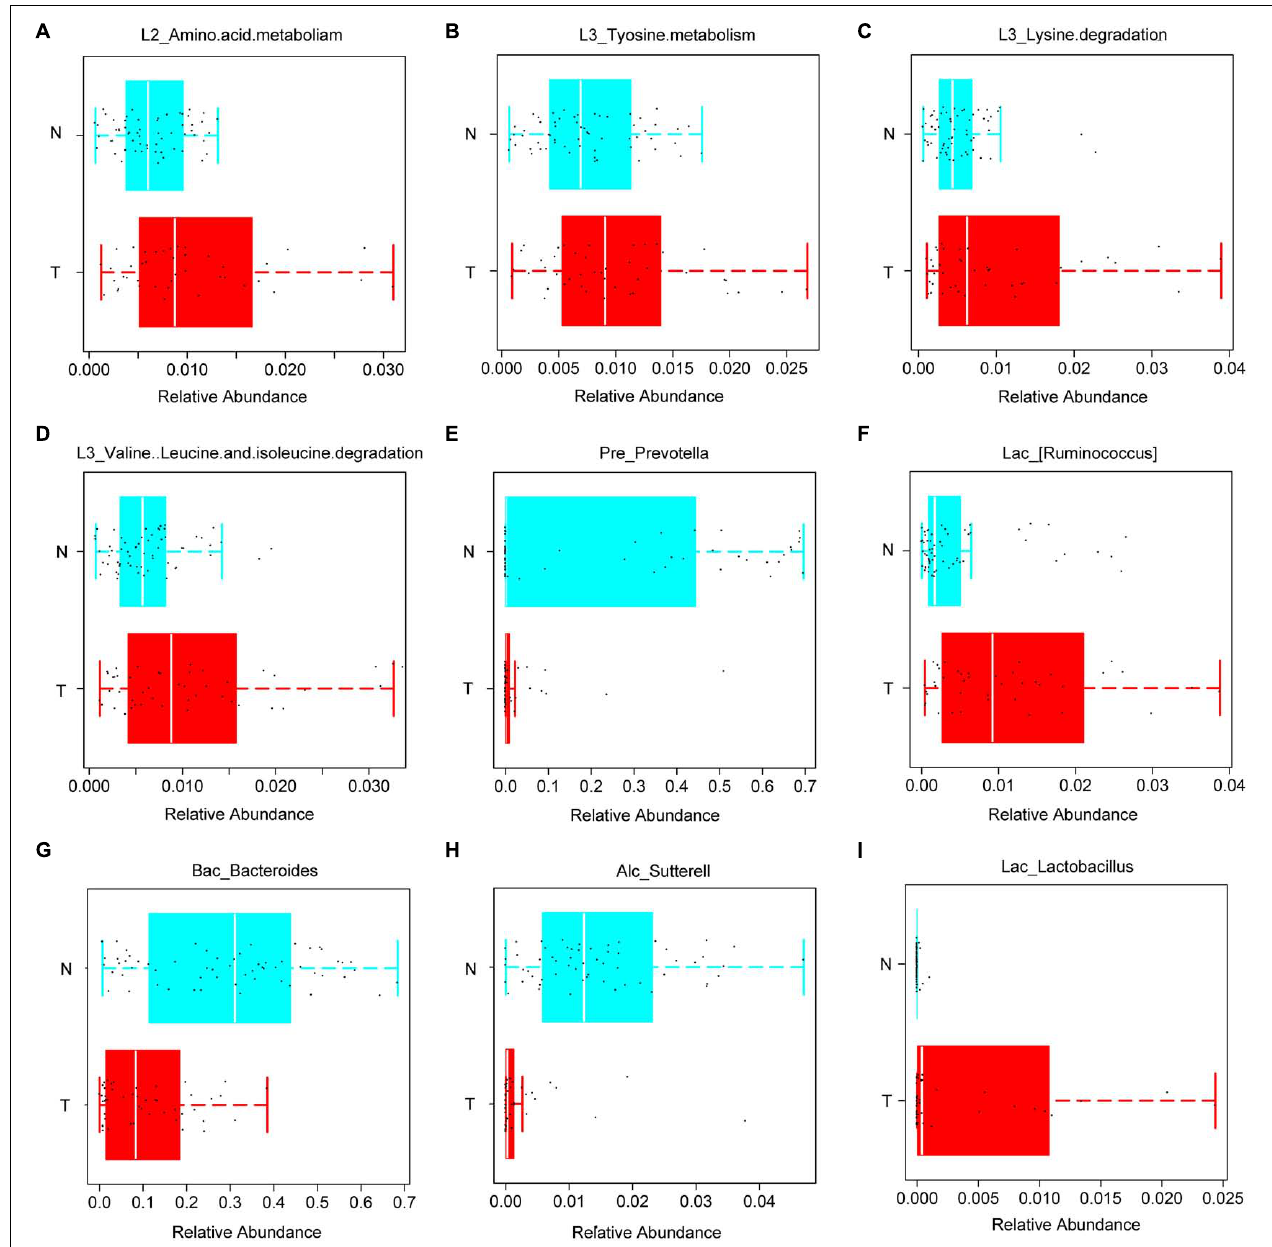
FIGURE 2 | KEGG functions and related bacteria in the CRC group (T) and healthy group (N). (A–D) The relative abundances of genera related to different KEGG functions in T and N groups; (E–I) bacteria with statistical difference between the T and N